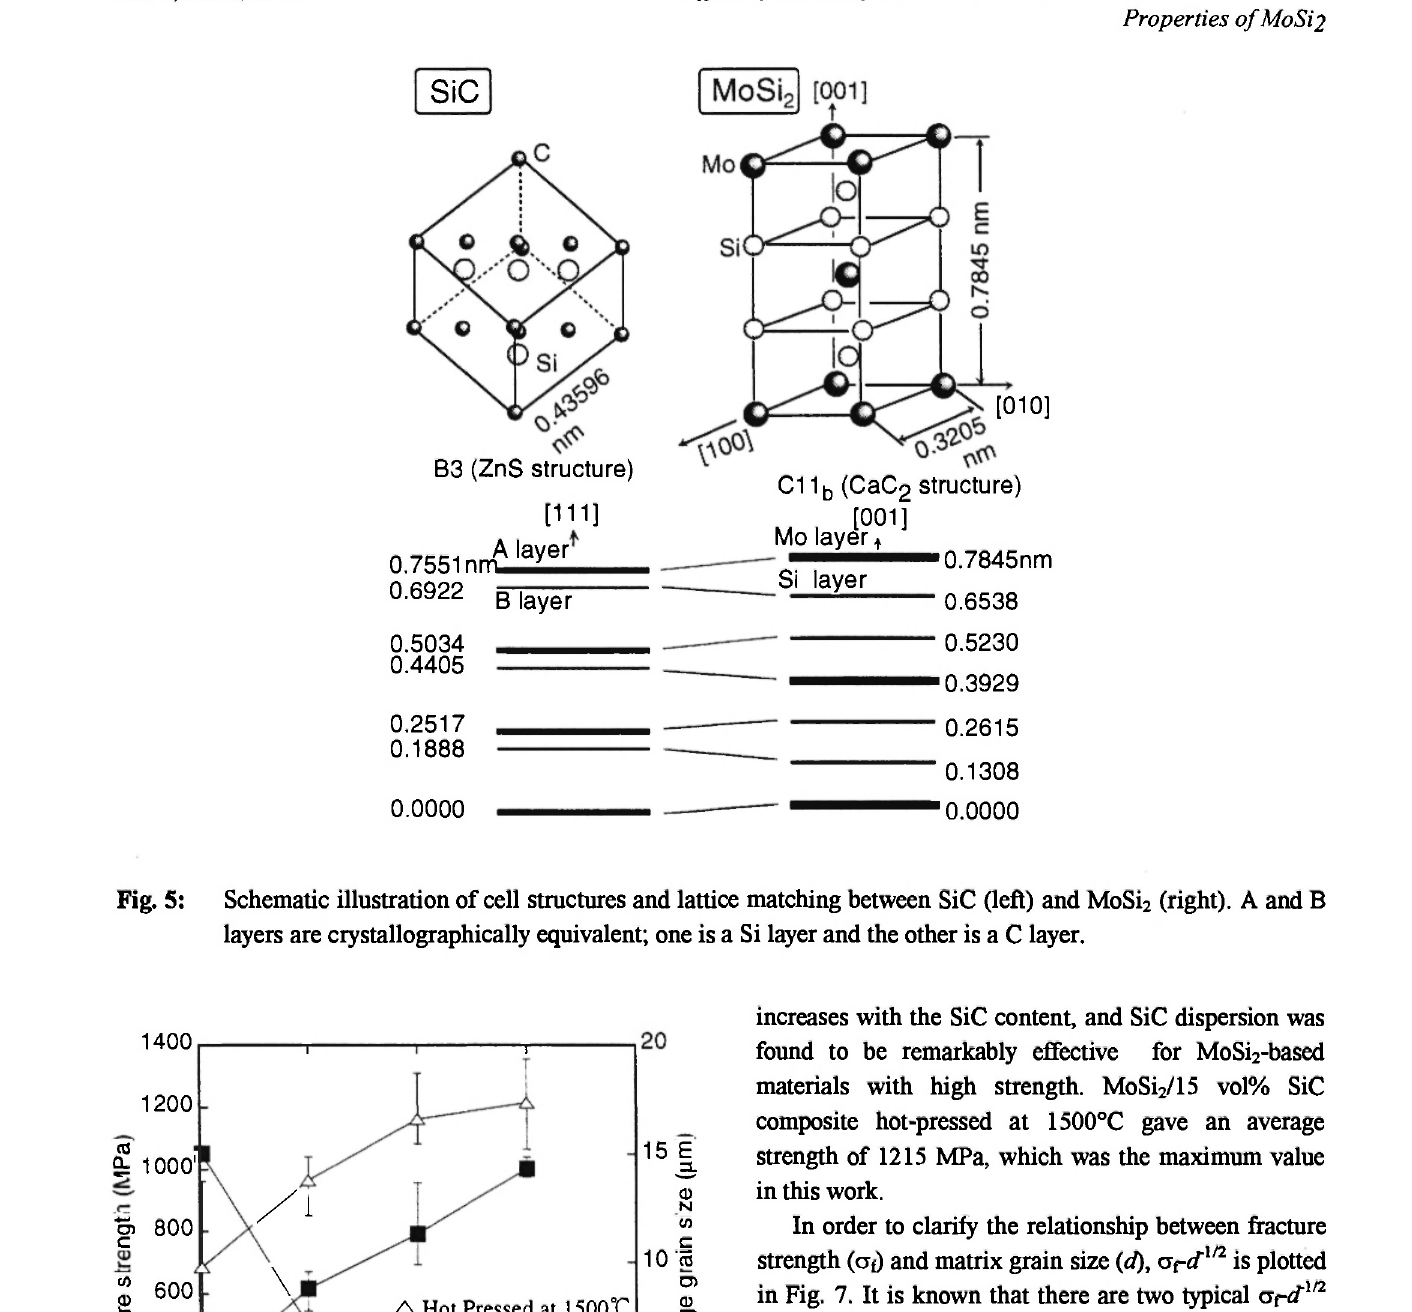
Fig. 6: Variations of fracture strength and matrix grain size with SiC content for MoSi MoSi /SiC composites. 2